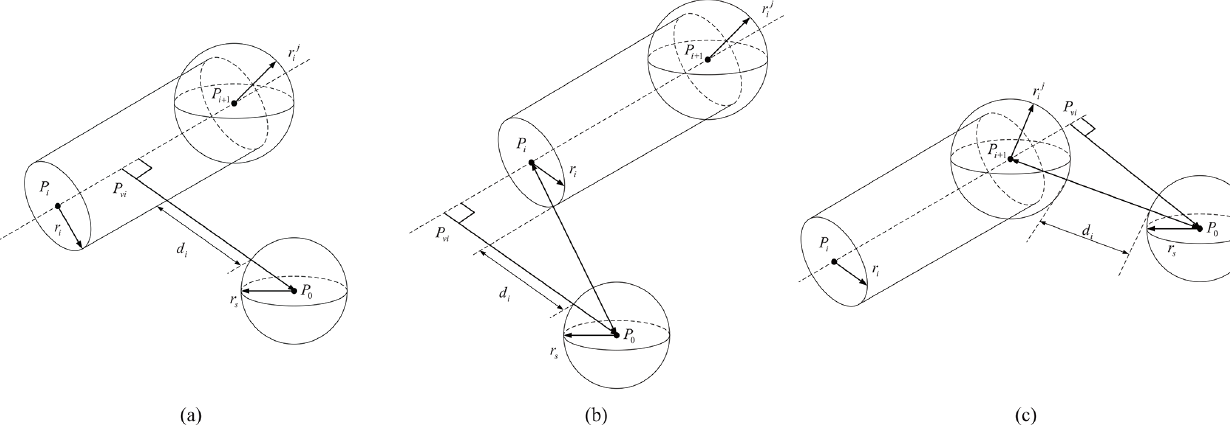
avoidance path planning for redundant manipulators is sum- marized as